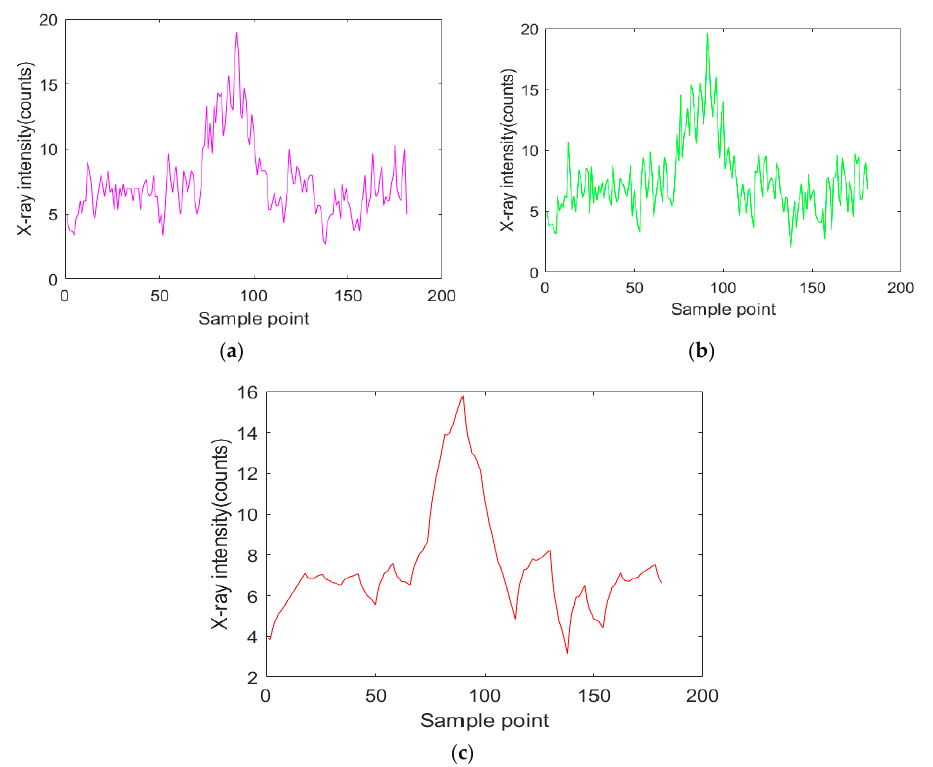
Figure 7. The signal processing results using different denoising algorithms: ( a ) the average filter; ( b ) the Kalman filter; ( c ) the wavelet packet.